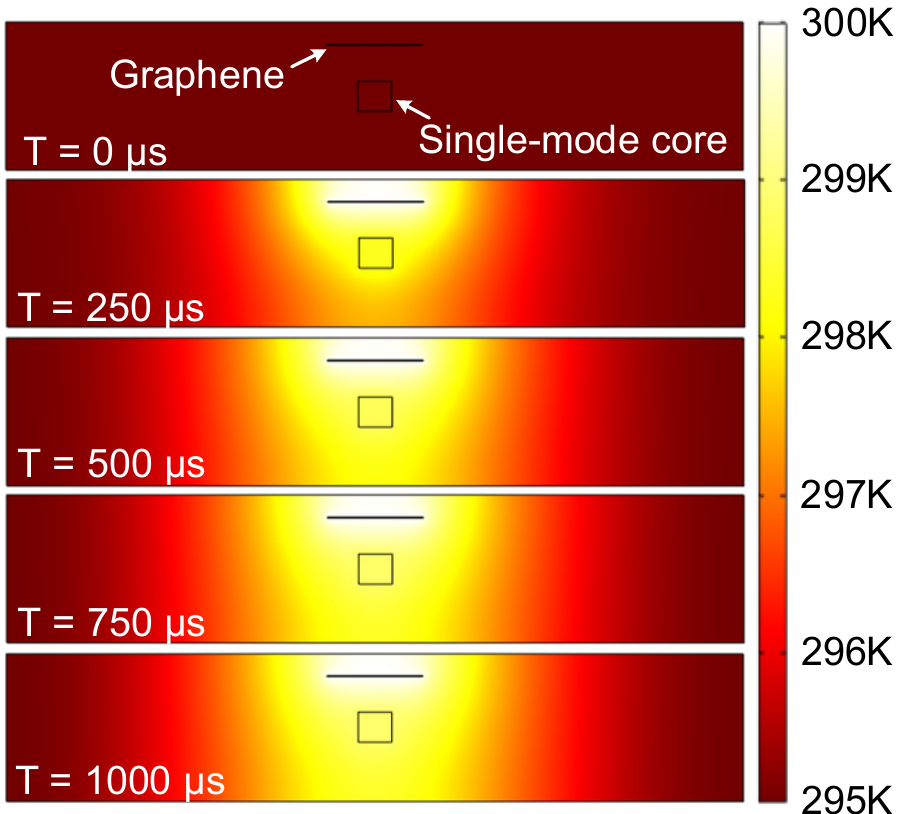
Figure 9. Schematic diagram for the thermal transfer process.